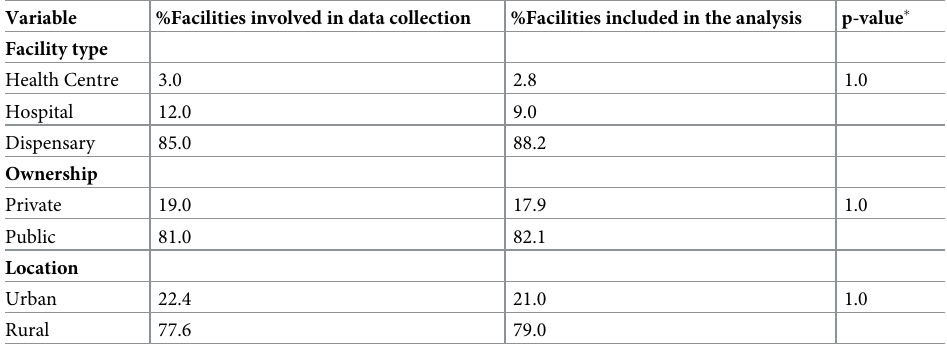
Table 4. A separate analysis output for 2766 (38%) PHC facilities that were excluded from final analysis.